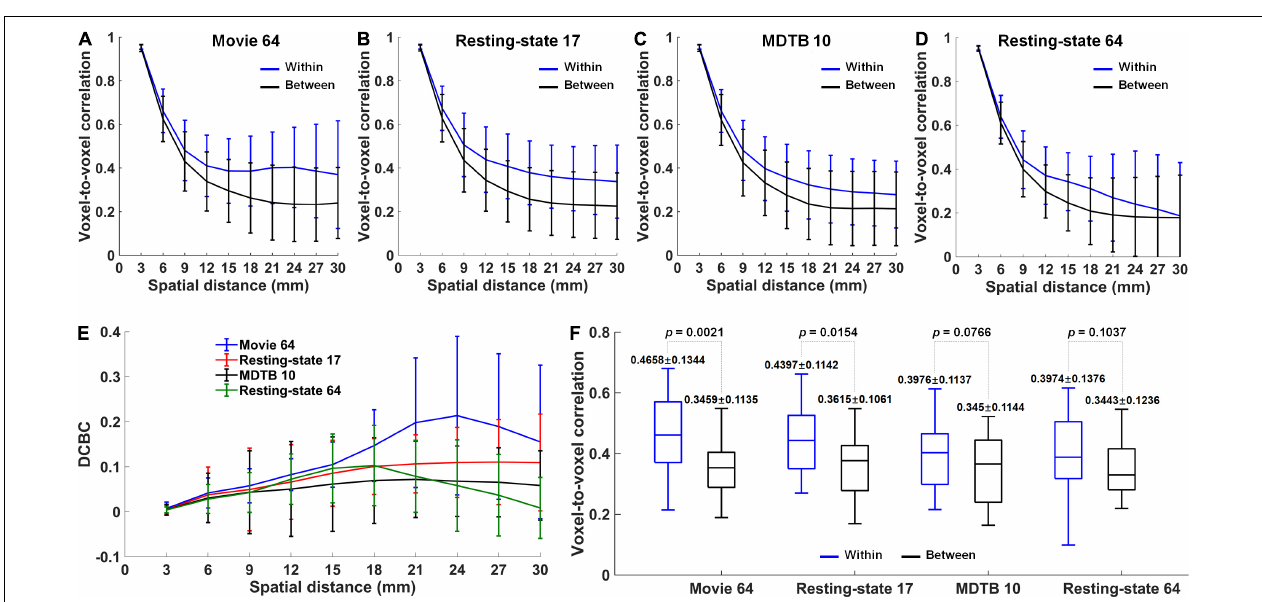
FIGURE 4 | (A–D) The correlations averaged over participants for within-region (blue) and between-region (black) voxel pairs in Movie 64, Resting-state 17, MDTB 10 and Resting-state 64 parcellations, respectively. (E) The DCBC values in the four parcellations. (F) The differences between within-region and between-region correlations averaged over spatial distance bins in the four